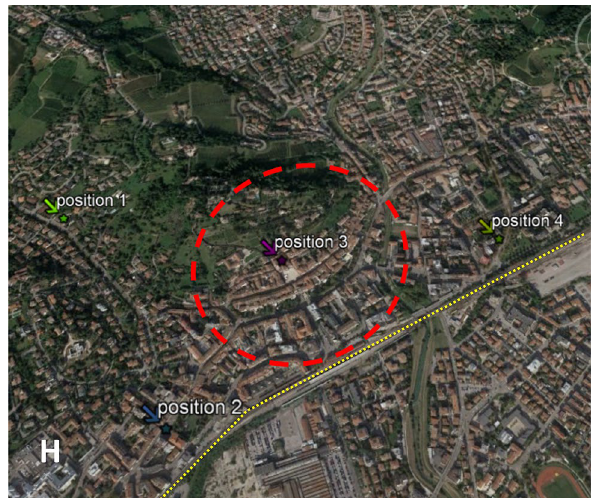
Figure 1. Italian city map. Dotted purple line identifies the historical city centre, while yellow one represent high-speed railway; capital H represents the Hospital position. Map realized using Google Earth version 7.3.3.7786 (32-bit), Maps data: Google, ©2021 CNES/Airbus, European Space imaging, Landsat, Copernicus, Maxar